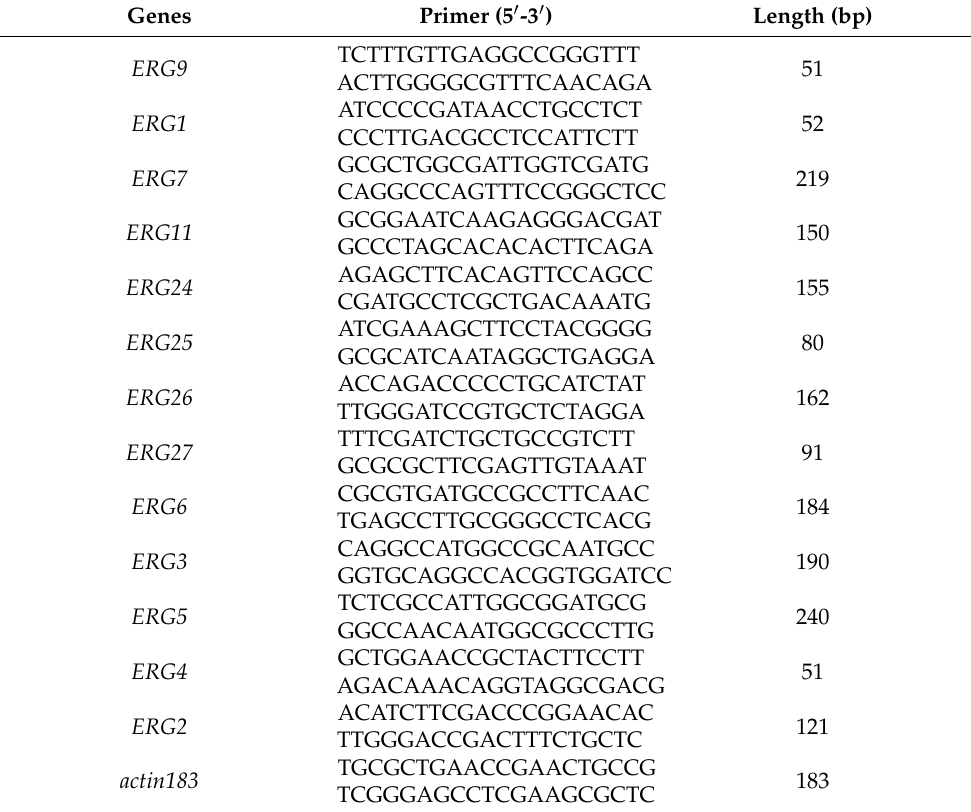
Table 1. Primer pair sequences designed for ERG genes in P. digitatum using RTFQ-PCR. Genes Primer (5 (cid:48) -3 (cid:48)